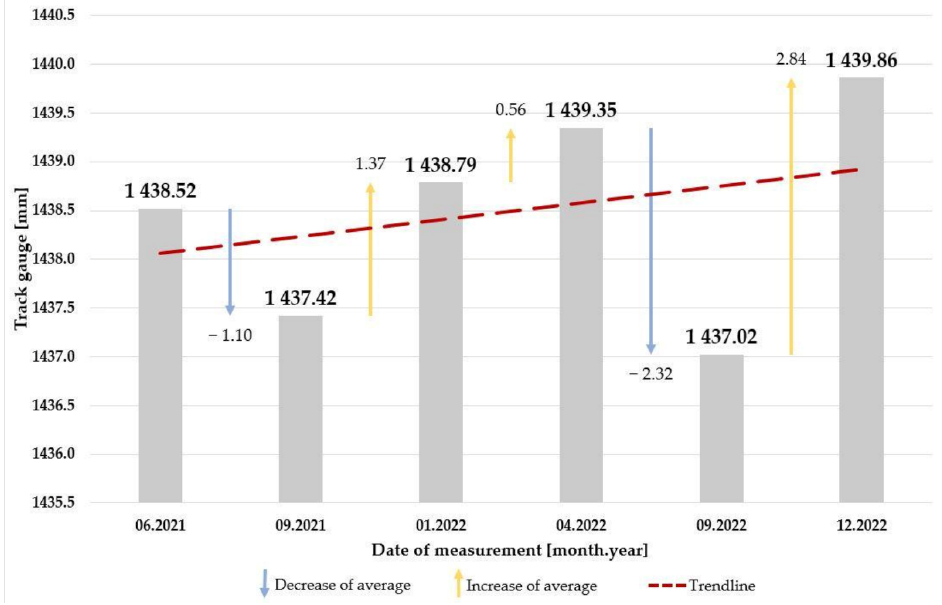
Figure 18. The change of average values of the track gauge in Section #5.